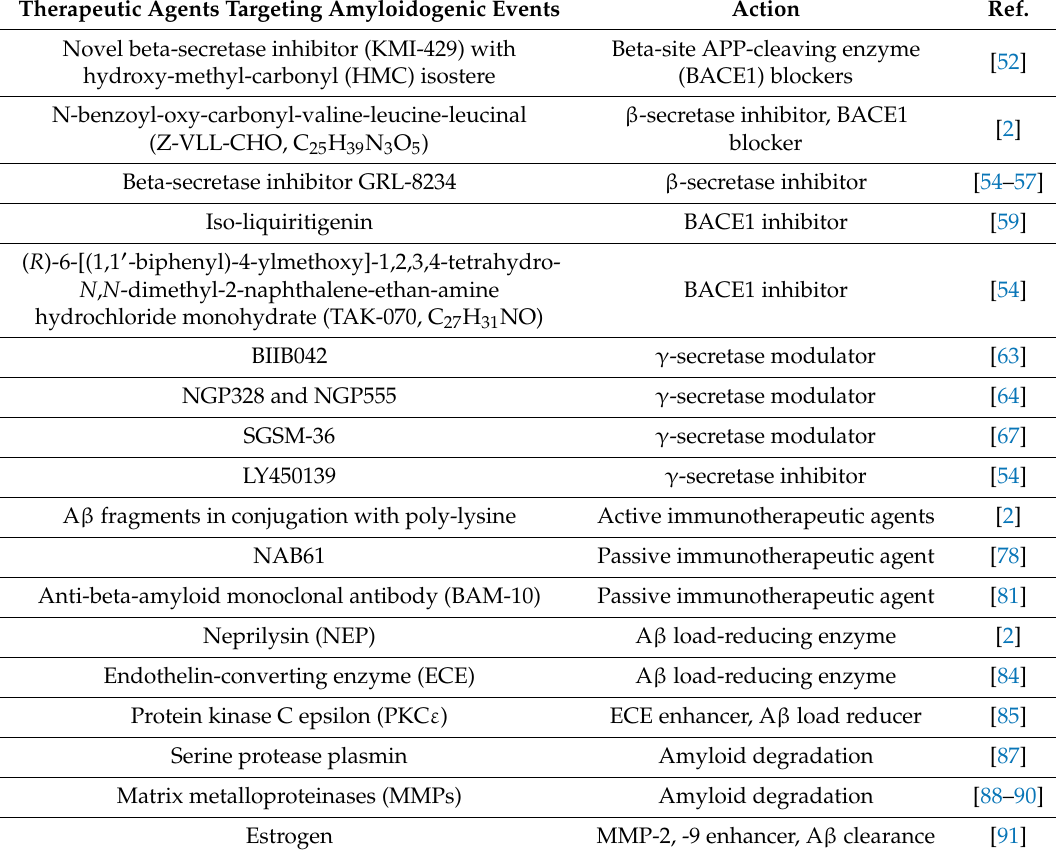
Figure 4. Flavonoid-mediated inhibition of glycogen synthase kinase-3 β (GSK-3 β ) and cyclin-dependent kinase-5 (CDK-5), which facilitates the blockage of A β aggregation, amyloid precursor protein (APP) alterations and tau phosphorylation. NFTs—Neurofibrillary tangles. Table 1. Therapeutic agents targeting A β peptides in Alzheimer’s disease (AD). Therapeutic Agents Targeting Amyloidogenic Events Action